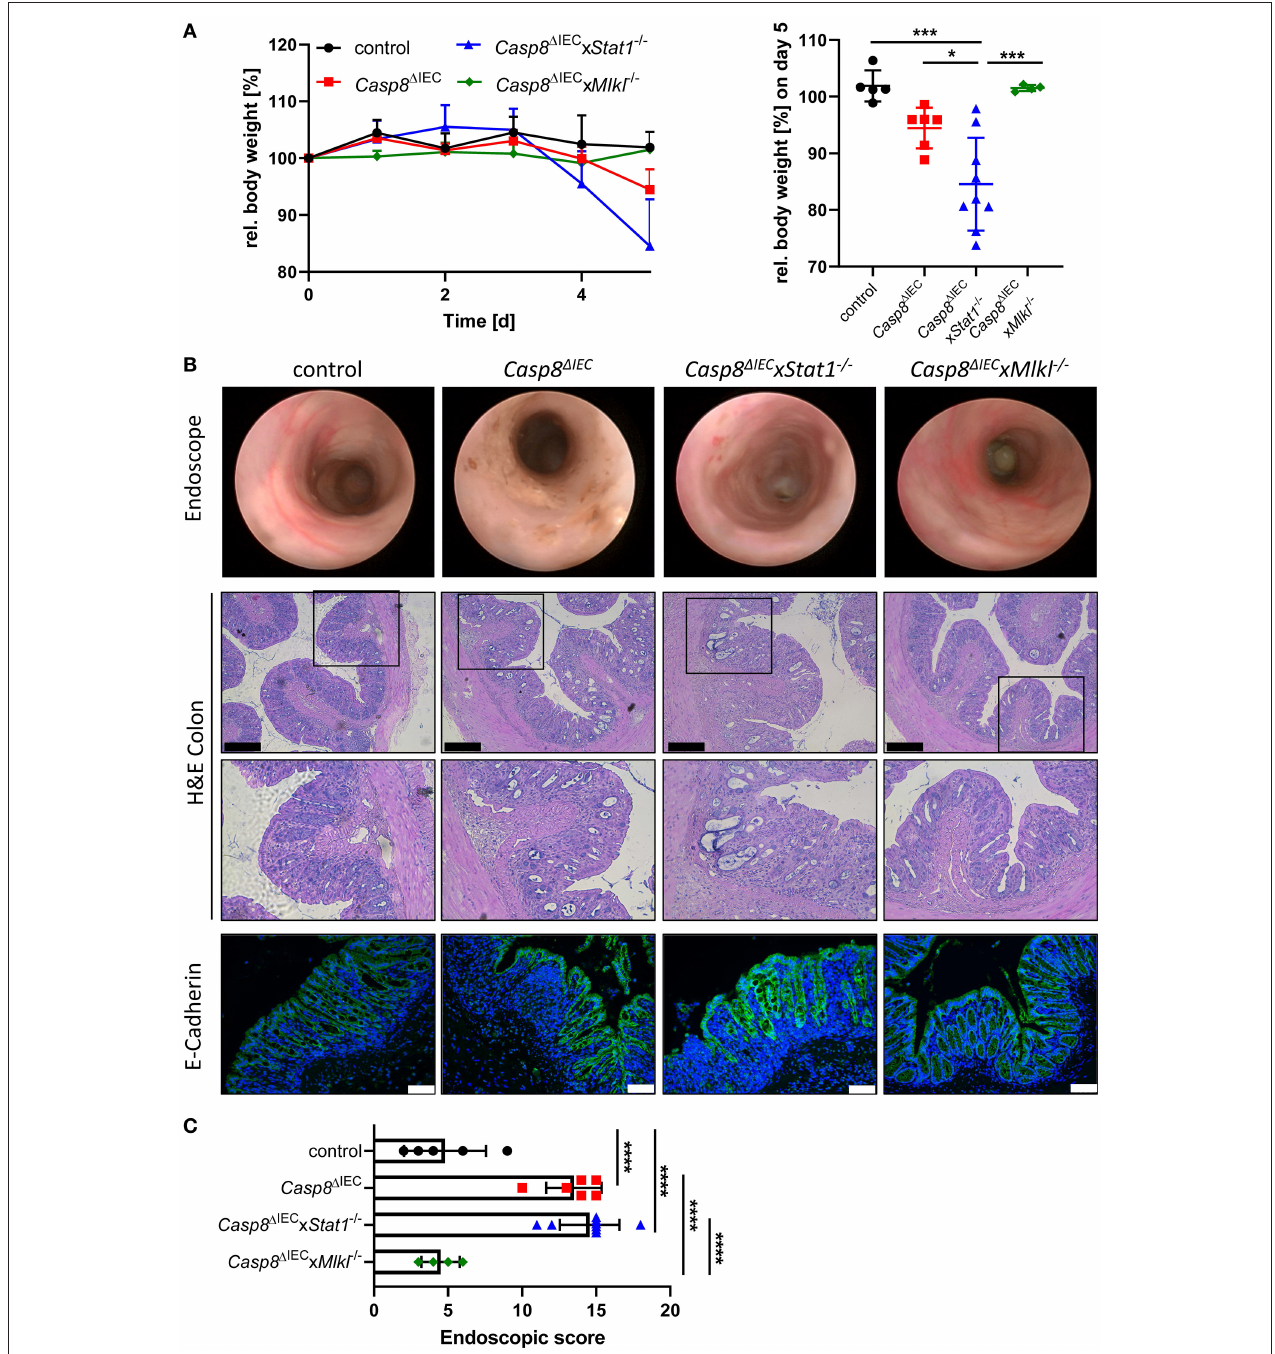
FIGURE 3 | Deletion of STAT1 does not ameliorate inflammation of Casp8 1 IEC mice during DSS colitis. (A) Relative body weight of control, Casp8 1 IEC , Casp8 1 IEC xStat1 − / − , Casp8 1 IEC x Mlkl − / − mice after administration of 2% DSS in drinking water. Mice were sacrificed at day 5. (B) Representative endoscopic pictures at day 5. Representative images of colonic cross sections stained with H&E (scale bar: 200 µ m) or immunohistochemically stained (scale bar: 75 µ m) with antibody against E-Cahderin (green). Nuclei were counterstained with Hoechst 33,342 (blue). (C) Endoscopic score. Error bars indicate + /-SD. Statistical analyses: One-way ANOVA with Tukey’s multiple comparisons test; NS p ≥ 0.05; * p < 0.05; ** p < 0.01; *** p < 0.001; **** p < 0.0001. Pooled data of two individual